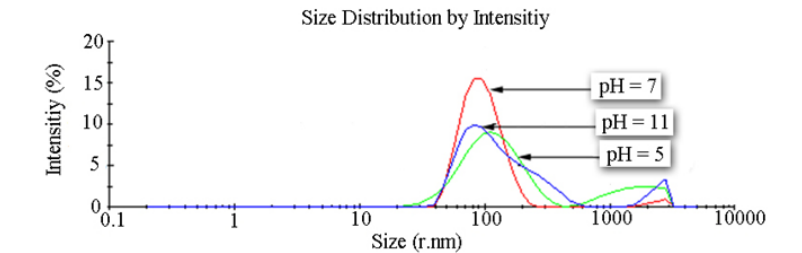
Figure 5. Effect of pH on drop size distribution.